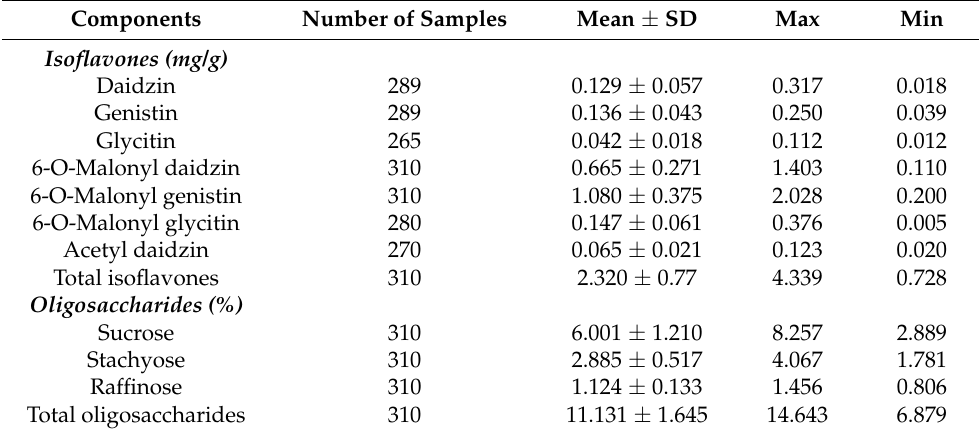
Table 1. The statistical data of targeted soybean components used for reference value of the predic- tion